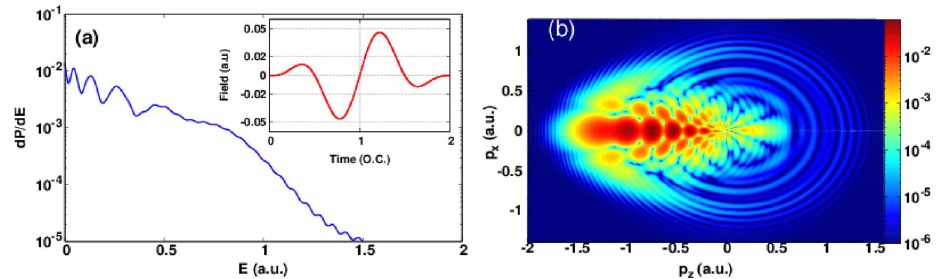
Figure 4. Same as Fig. 1 but for optical cycles N = 2.